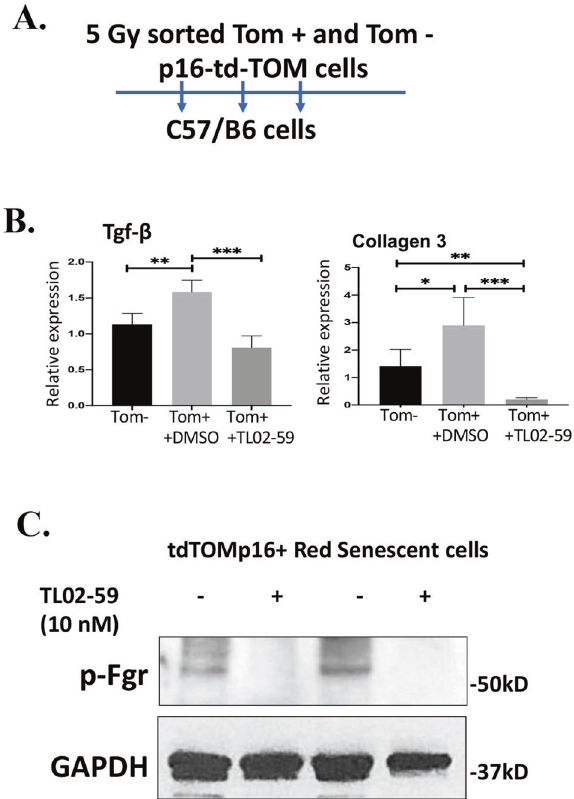
Fig. 5 In transwell culture, inhibition of tyrosine kinase Fgr by TL02-59 abrogates the induction of pro fi brotic genes in target cells. A Irradiated tdTOMp16 + non-senescent (tdTOM − ) and senescent (tdTOM + ) cells were cultured on the top well of the transwell, and the target C57BL/6 stromal cells were cultured on the bottom well. Cells were treated with either vehicle or 10 nM Fgr inhibitor TL02-59 and after 10 days, target cells were harvested for RNA, and RT-qPCR was performed for TGF- β and Collagen 3 genes. B Inhibition of Fgr phosphorylation by TL02-59 was con fi rmed by western blot from the vehicle and TL02-59-treated cell lysates of irradiated senescent (tdTOM + ) cells ( n = 3, * P = <0.05; ** P = 0.01). C Phosphorylation of Fgr was inhibited by TL02-59. NS non- signi fi cant), P values were calculated by t